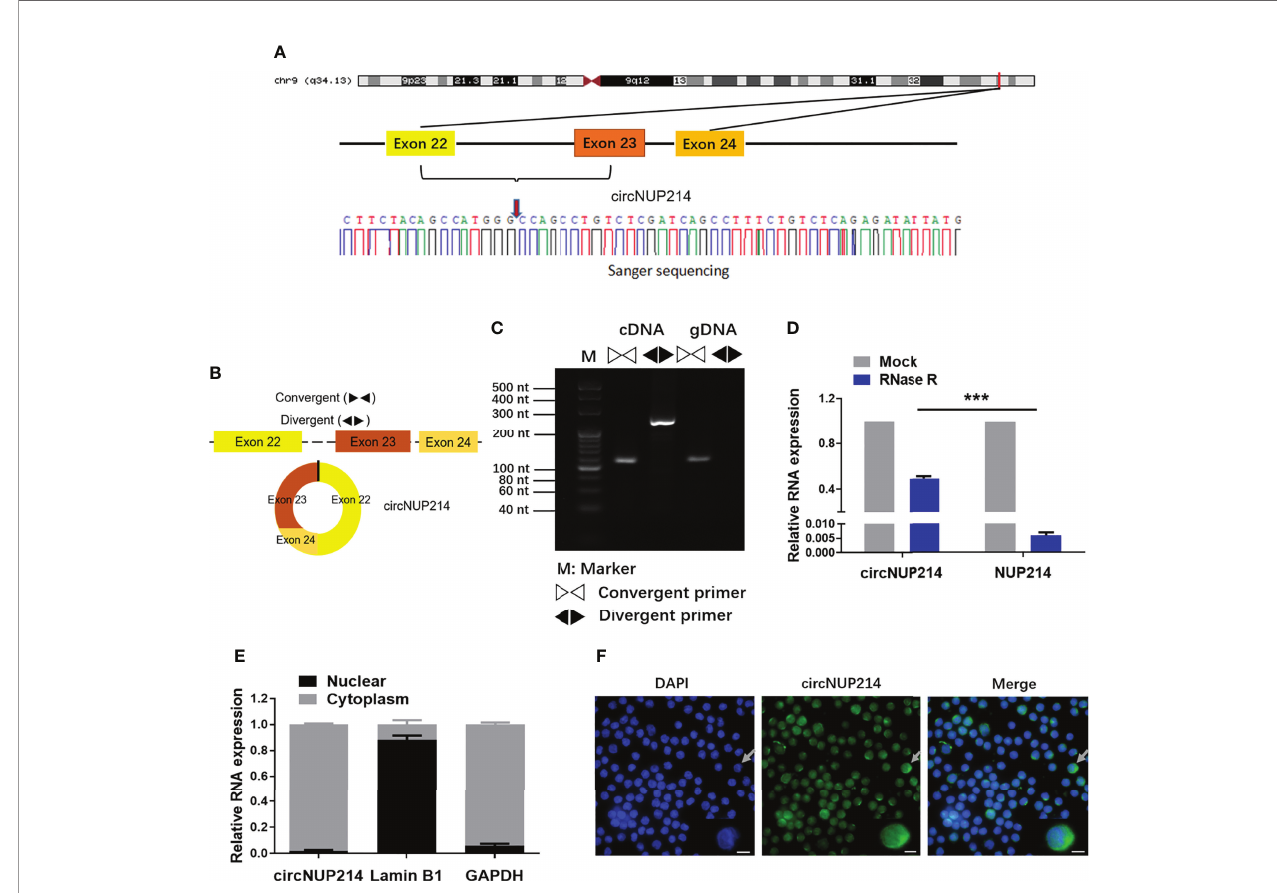
FIGURE 1 | Characterization of circNUP214. (A) Genomic position of circNUP214 on the human chromosome and Sanger sequencing following PCR con fi rmed the ‘ head-to-tail ’ splicing of circNUP214 in PBMCs. The red arrow represents backsplicing junction site. (B) Convergent and divergent primers of circNUP214 were designed to amplify the linear or back-splicing products. (C) qRT – PCR products with divergent primers showing the circularization of circNUP214. cDNA: complementary DNA. gDNA: genomic DNA. (D) The relative expression of circNUP214 and NUP214 mRNA after the treatment with RNase R in PBMCs was determined by qRT – PCR. (E) Cytoplasmic and nuclear fractionation experiment showed that circNUP214 was mainly localized in the cytoplasm. GAPDH and Lamin B1 were applied as positive controls in the cytoplasm and nucleus, respectively. Data represent mean ± S.D. from three independent experiments. (F) RNA fl uorescence in situ hybridization of circNUP214. Nuclei were stained with DAPI. Scale bar, 25 µm. *** p <